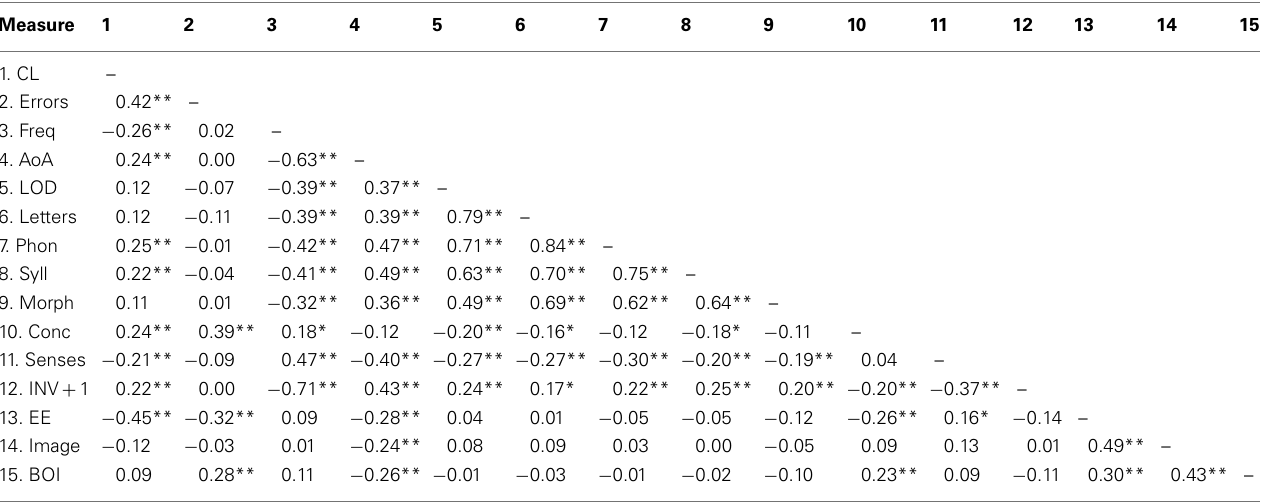
Table 3 | Zero-order correlations between the criterion variables and the predictor variables for the abstract SCT.